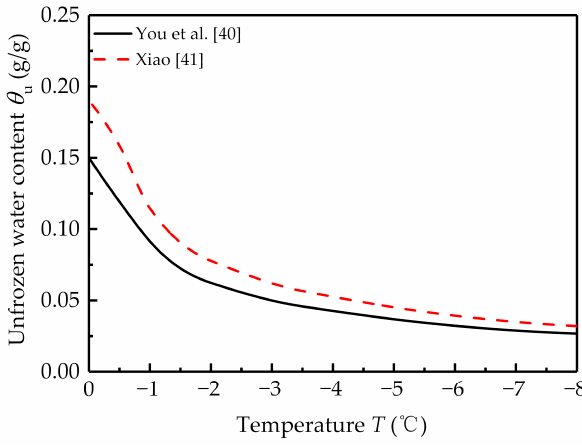
Figure 11. Soil freezing curves of the soils.